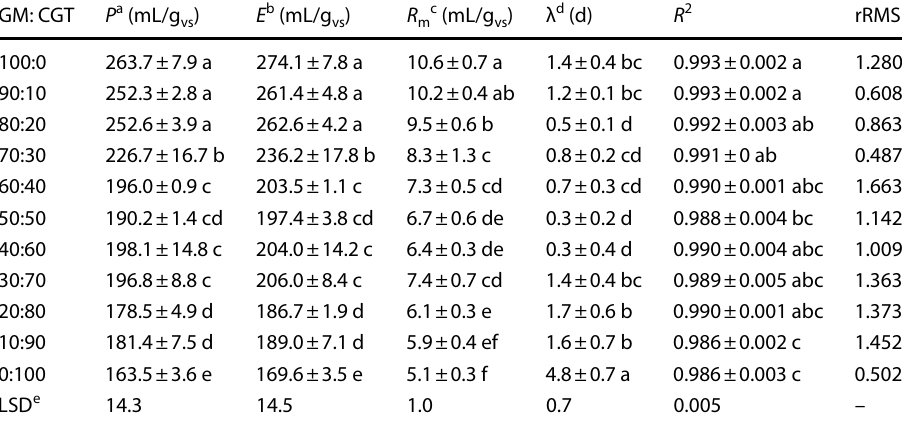
Each value is a mean ± SD from triplicates. The values across a column sharing the same letter are similar at α =